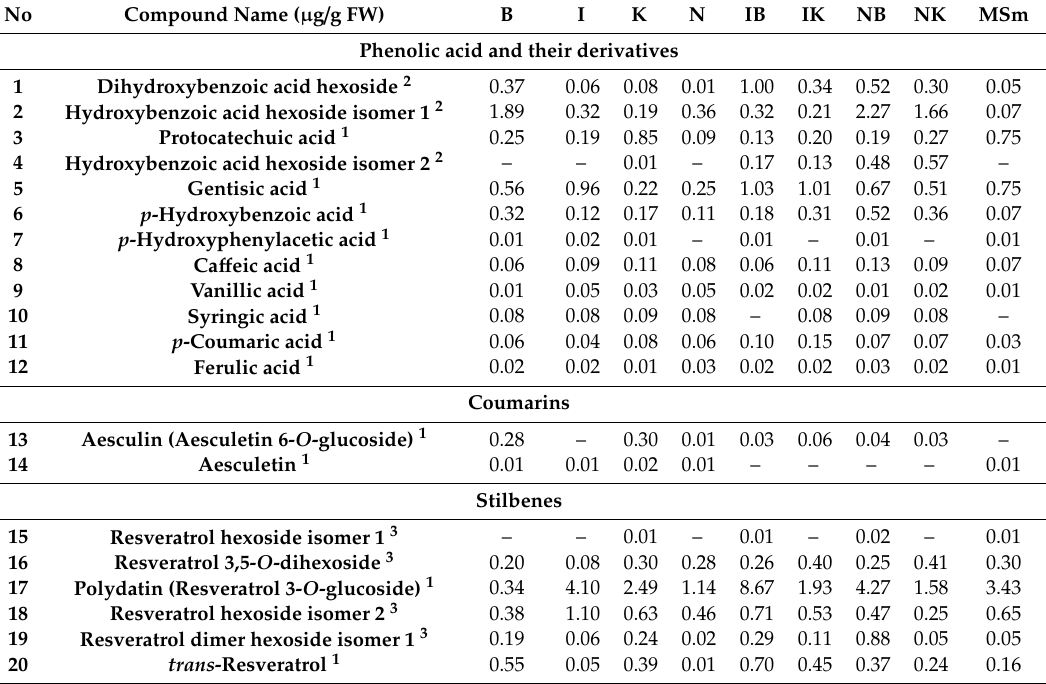
Table 3. The individual polyphenolic content (µg/g FW) determined by LC/MS for the different plant growth regulator (PGR) treatments.